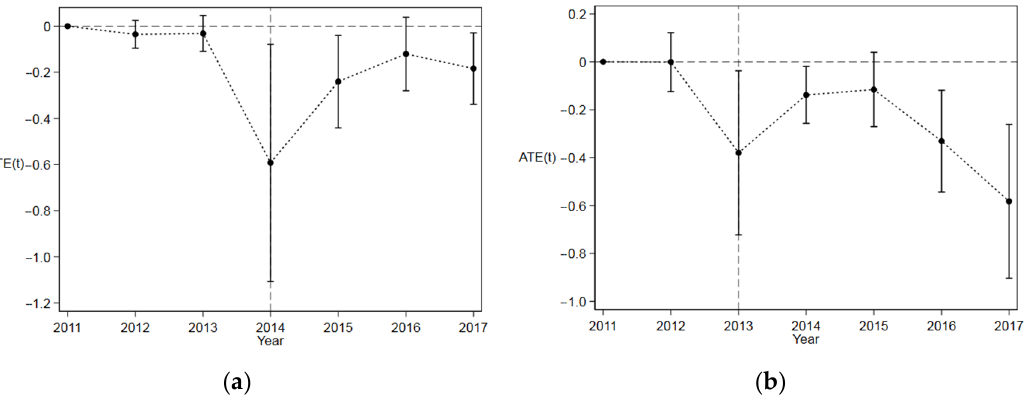
Figure 3. Parallel trend assumption tests. ( a ) CETS (starting in 2014) for the ELT; ( b ) CETS (starting in 2013) for the